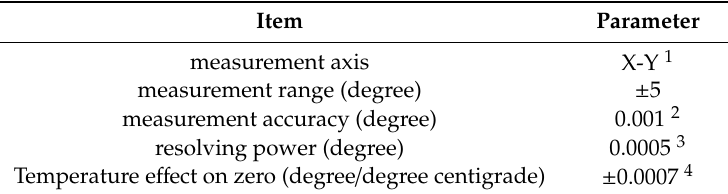
Table 1. Parameters of the tilt compensator.